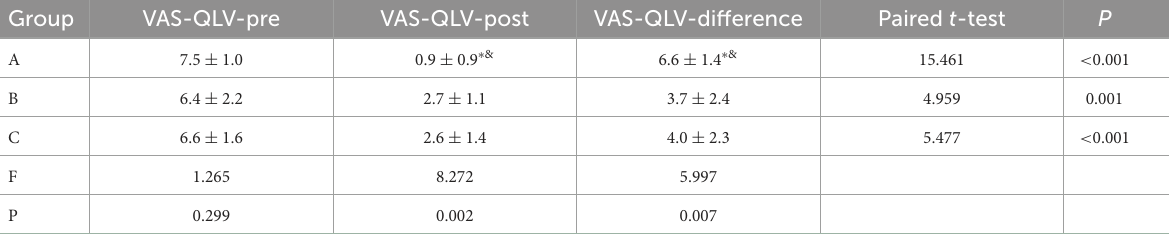
Figure 1. The results of Pearson correlation analysis showed that there was no significant correlation between age and VAS-A in either group A or group B ( P >